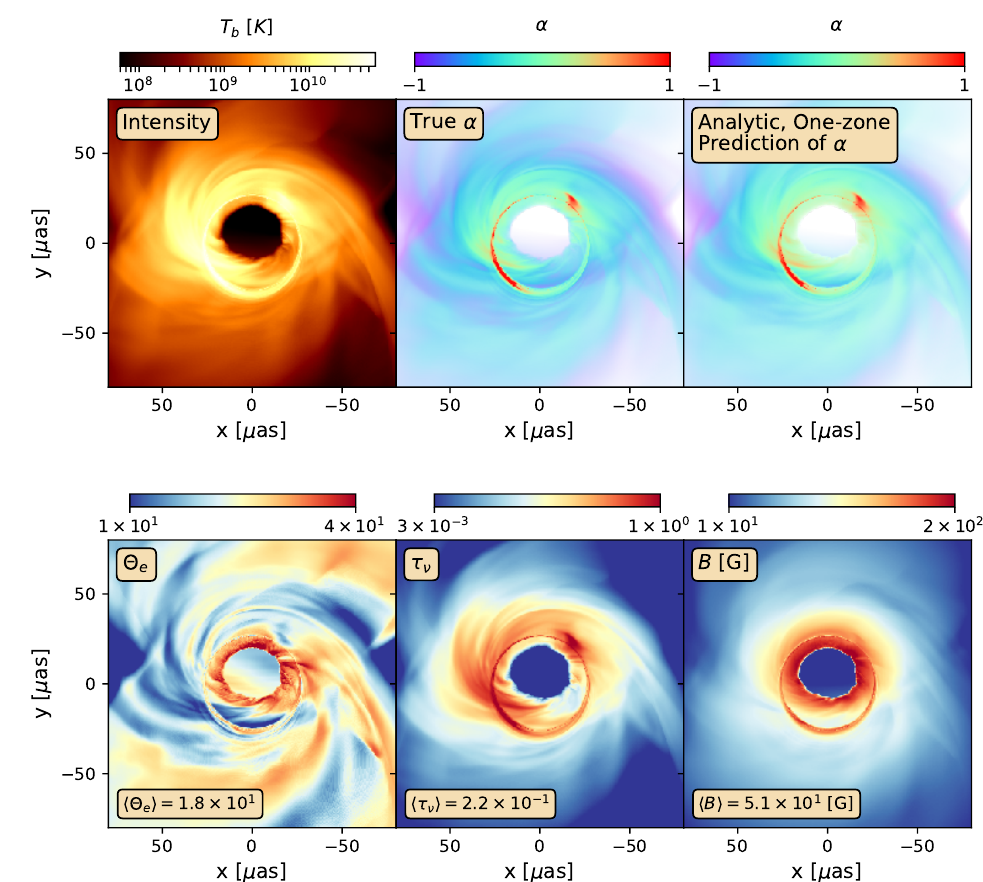
Figure 2. Intensity and spectral index map of a MAD model of Sgr A* adapted from Figure 4 of [41]. The top left panel plots total intensity in log scale averaged between 214 and 228 GHz, the top center panel plots the spectral index across this bandwidth calculated by ray tracing the image at two different frequencies, and the top right panel plots an analytic prediction of the spectral index in each pixel obtained by combining the three quantities in the bottom panel: electron temperature, optical depth, and magnetic field strength, each computed by performing an emissivity-weighted average long each geodesic. The excellent agreement between the true spectral index map and the analytic prediction illustrates the power of spectral index maps to jointly constrain these plasma